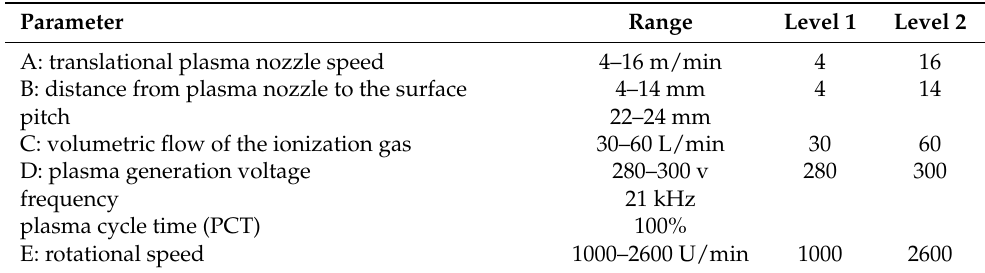
Table 1. Process parameters of plasma treatment and factors of fractional factorial design.